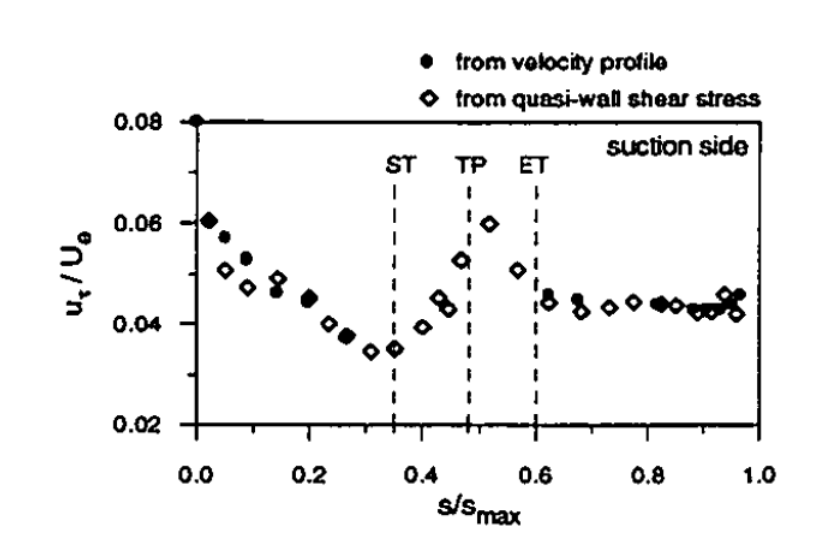
Figure A3. Wall friction velocity distributions on the blade suction side.